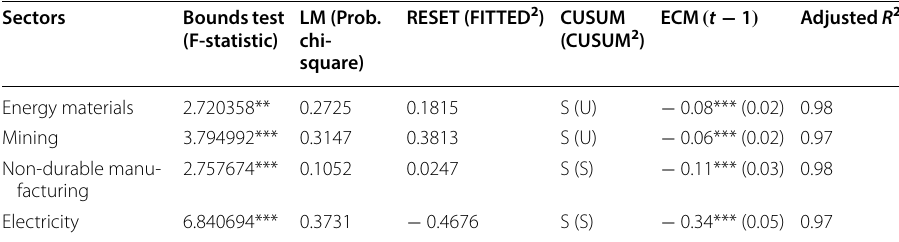
Table 7 Diagnostic tests for ARDL estimates